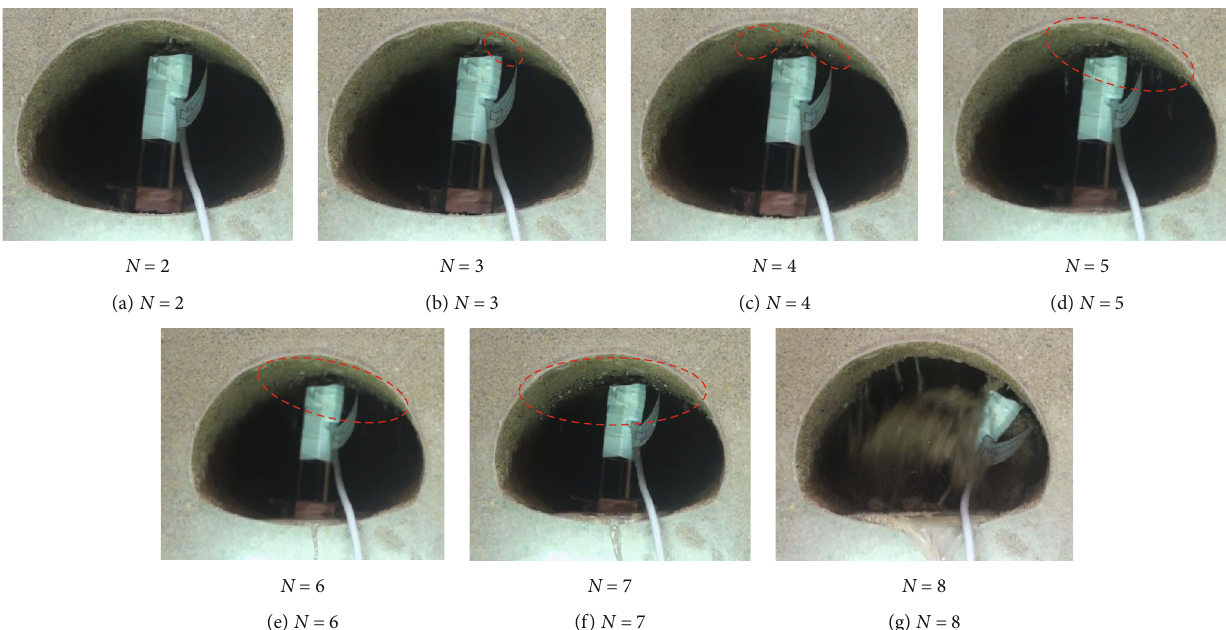
Figure 5: Water gushing process of tunnel surrounding rock subjected to the wetting-drying alternation (note: the dotted line denotes the area where seepage water appears).